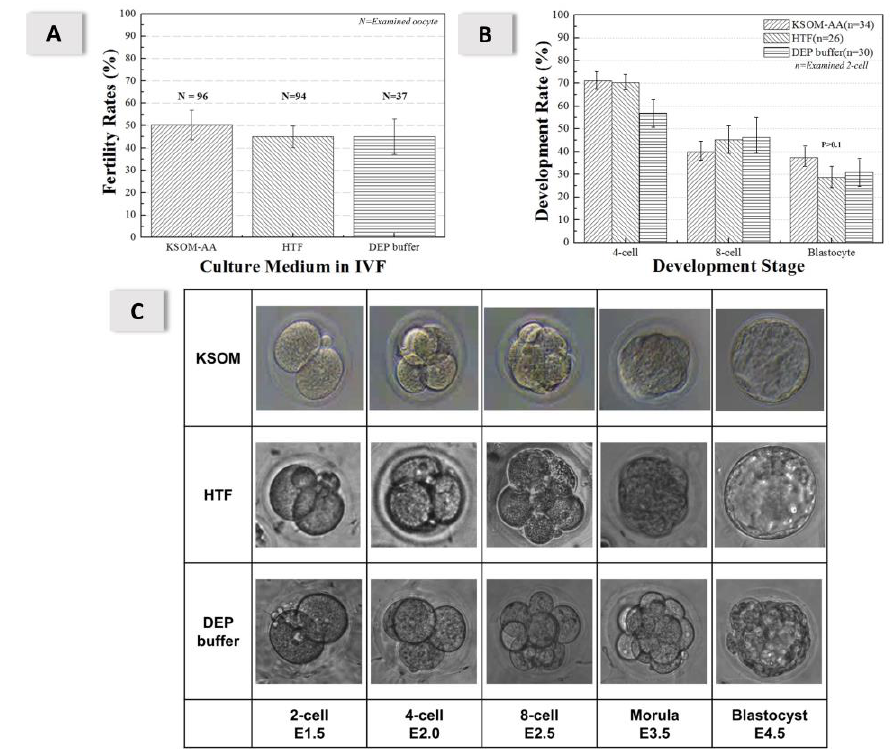
Figure 3. ( A ) Rates of fertilization in vitro under KSOM-AA (50.2 ± 6.6%; n = 96), HTF (45.0 ± 4.8%; n = 94), and DEP buffer solution (45.1 ± 7.9%; n = 37). There is no significantly statistical difference among conditions ( p > 0.1). ( B ) Blastocyst rates under KSOM-AA (37.4 ± 8.0%; n = 34), HTF (28.6 ± 12.2%; n = 26), and DEP buffer solution (30.9 ± 13.2%; n = 30), respectively; there is no significantly statistical difference ( p > 0.1). ( C ) Tracking of embryo development of these three groups with an optical microscope at six periods (E1.5, E2.0, E2.5, E3.0, E3.5, E4.0, and E4.5 days); magnification 40×. (All sizes of embryo pictures are about 100 μ m 100 μ m).